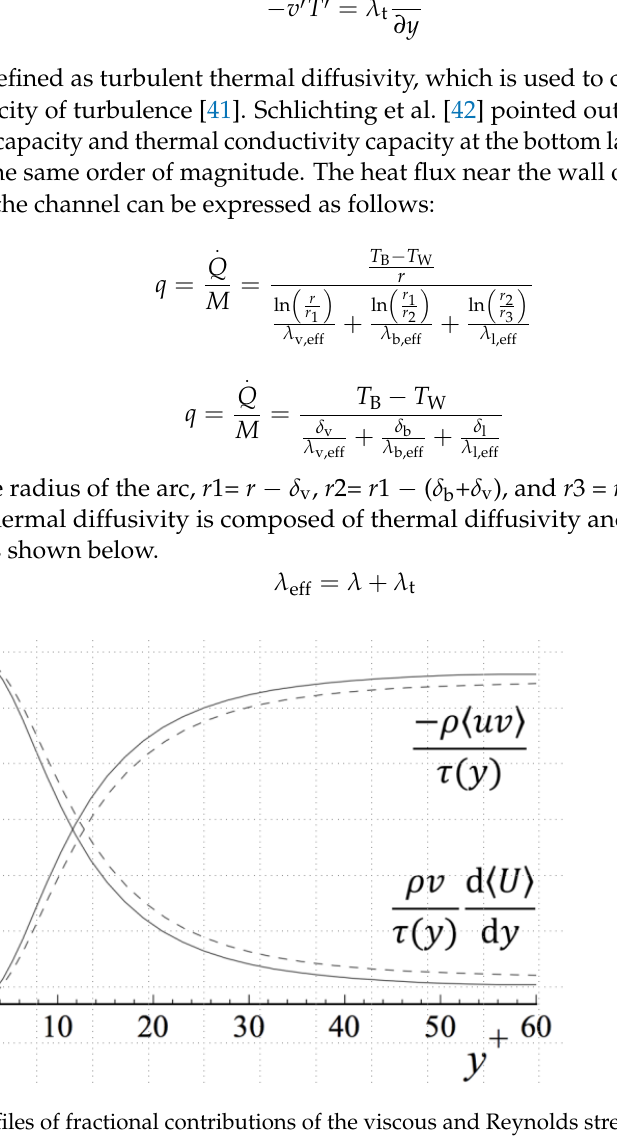
(b) Figure 11. The physical process ( a ) of Equation (21) and the physical process ( b ) of Equation (22). The contribution of 𝜆 and 𝜆 t to 𝜆 eff , along with y + in one local section, is shown in Figure 12.